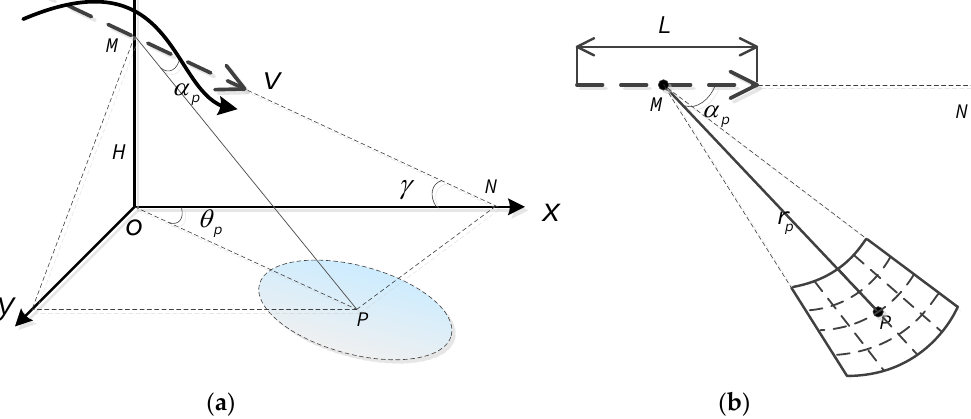
Figure 1. SAR imaging geometric model of high maneuvering platforms; ( a ) Cartesian coordinate system, ( b ) polar coordinate system.